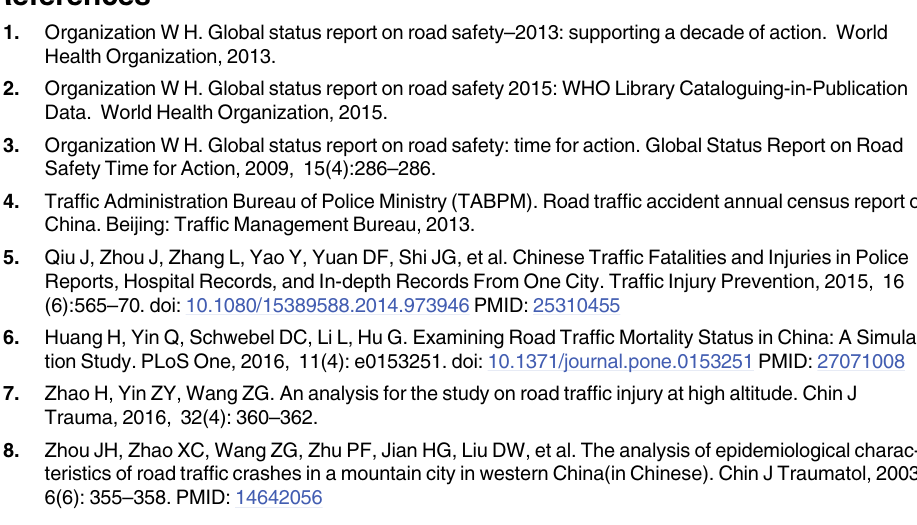
S7 Table. Road traffic-pertinent elements in Chongqing from 2006 to 2013. The informa- tion was compiled from annual census data issued by the Bureau of Traffic Management of the Ministry of Public Security of the People’s Republic of China. S8 Table. National road traffic-pertinent elements from 2006 to 2013. The information was compiled from annual census data issued by the Bureau of Traffic Management of the Ministry of Public Security of the People’s Republic of